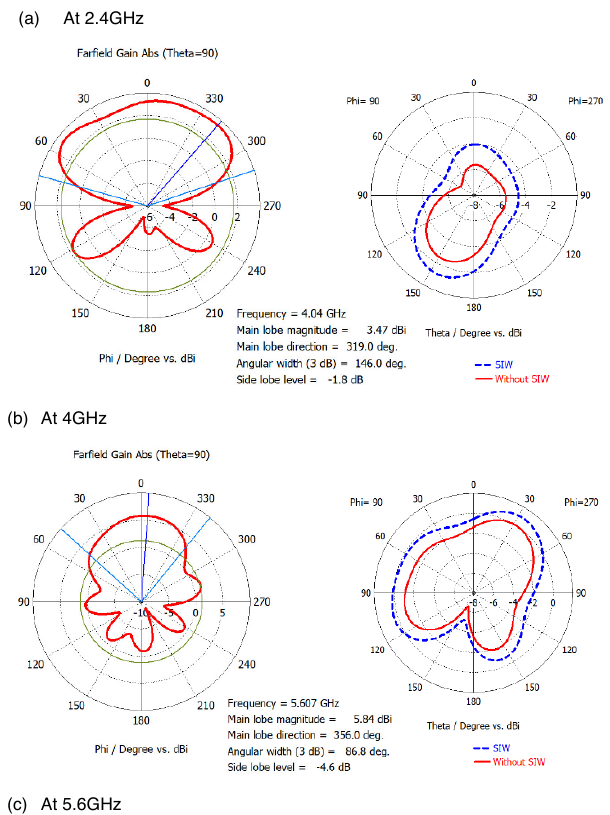
FIGURE 8. 2D radiation of the SIW-Vivaldi